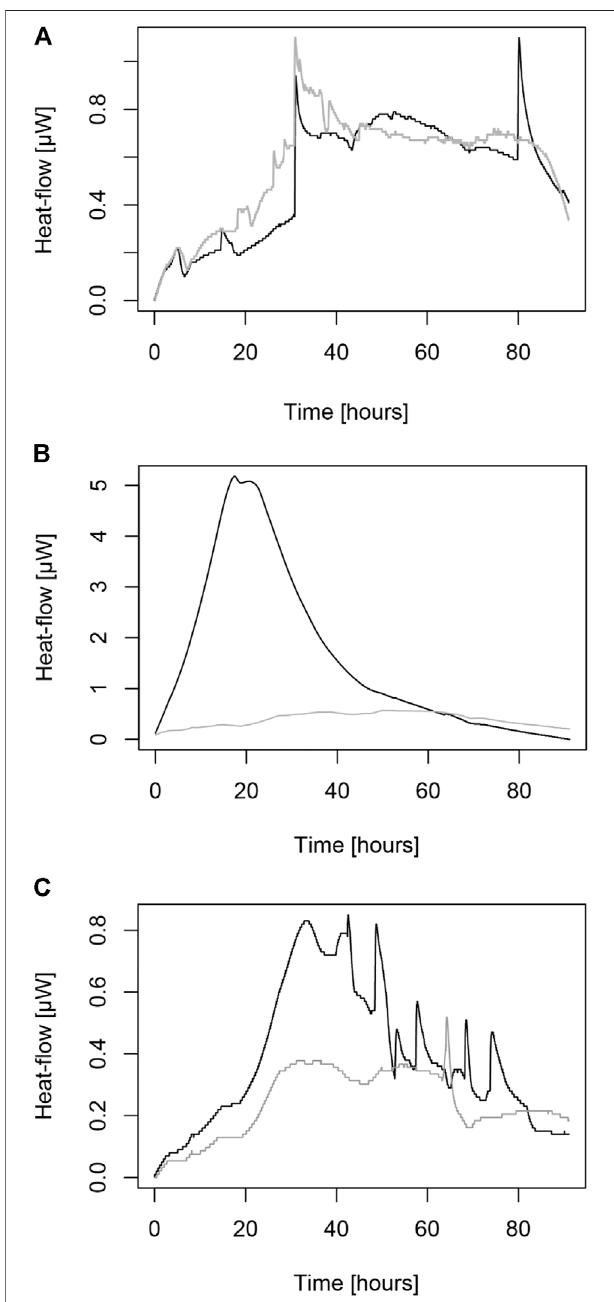
FIGURE2| ThermogramsofIMCshowingtheheat- fl owofCdmetabolic activity in soils. (A) the heat- fl ow of soils from Antioquia. (B) the heat- fl ow of soils from Arauca. (C) the heat- fl ow of soils from Santander. Grey lines correspond to samples with natural Cd content. Black lines correspond to the metabolic activity of samples amended with 1 mg kg − 1 of